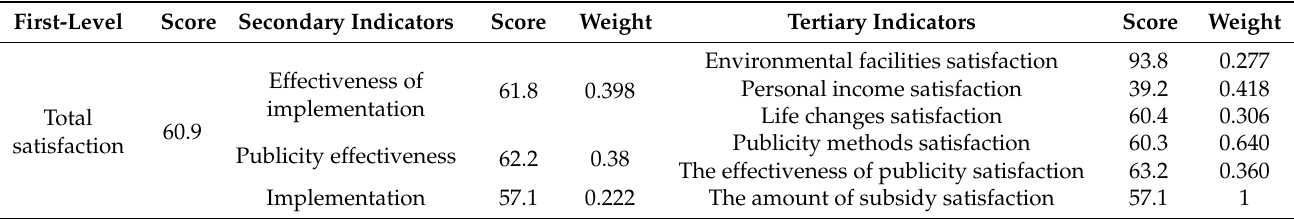
Table 7. The CCLBP of natural forests satisfaction overall